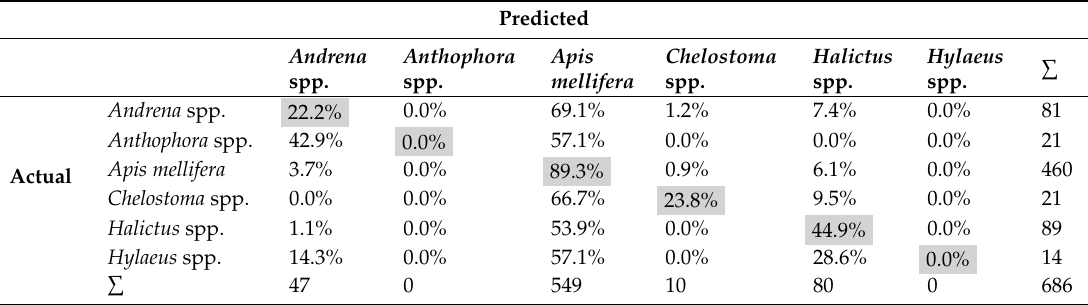
Table 3. Confusion matrices summarizing the percentages of visitors correctly identified by the random forest models (shaded diagonals), and the frequencies of misidentifications. Tables 2 and 3, respectively, summarize models with only shape-related or only phenology-related explanatory variables.